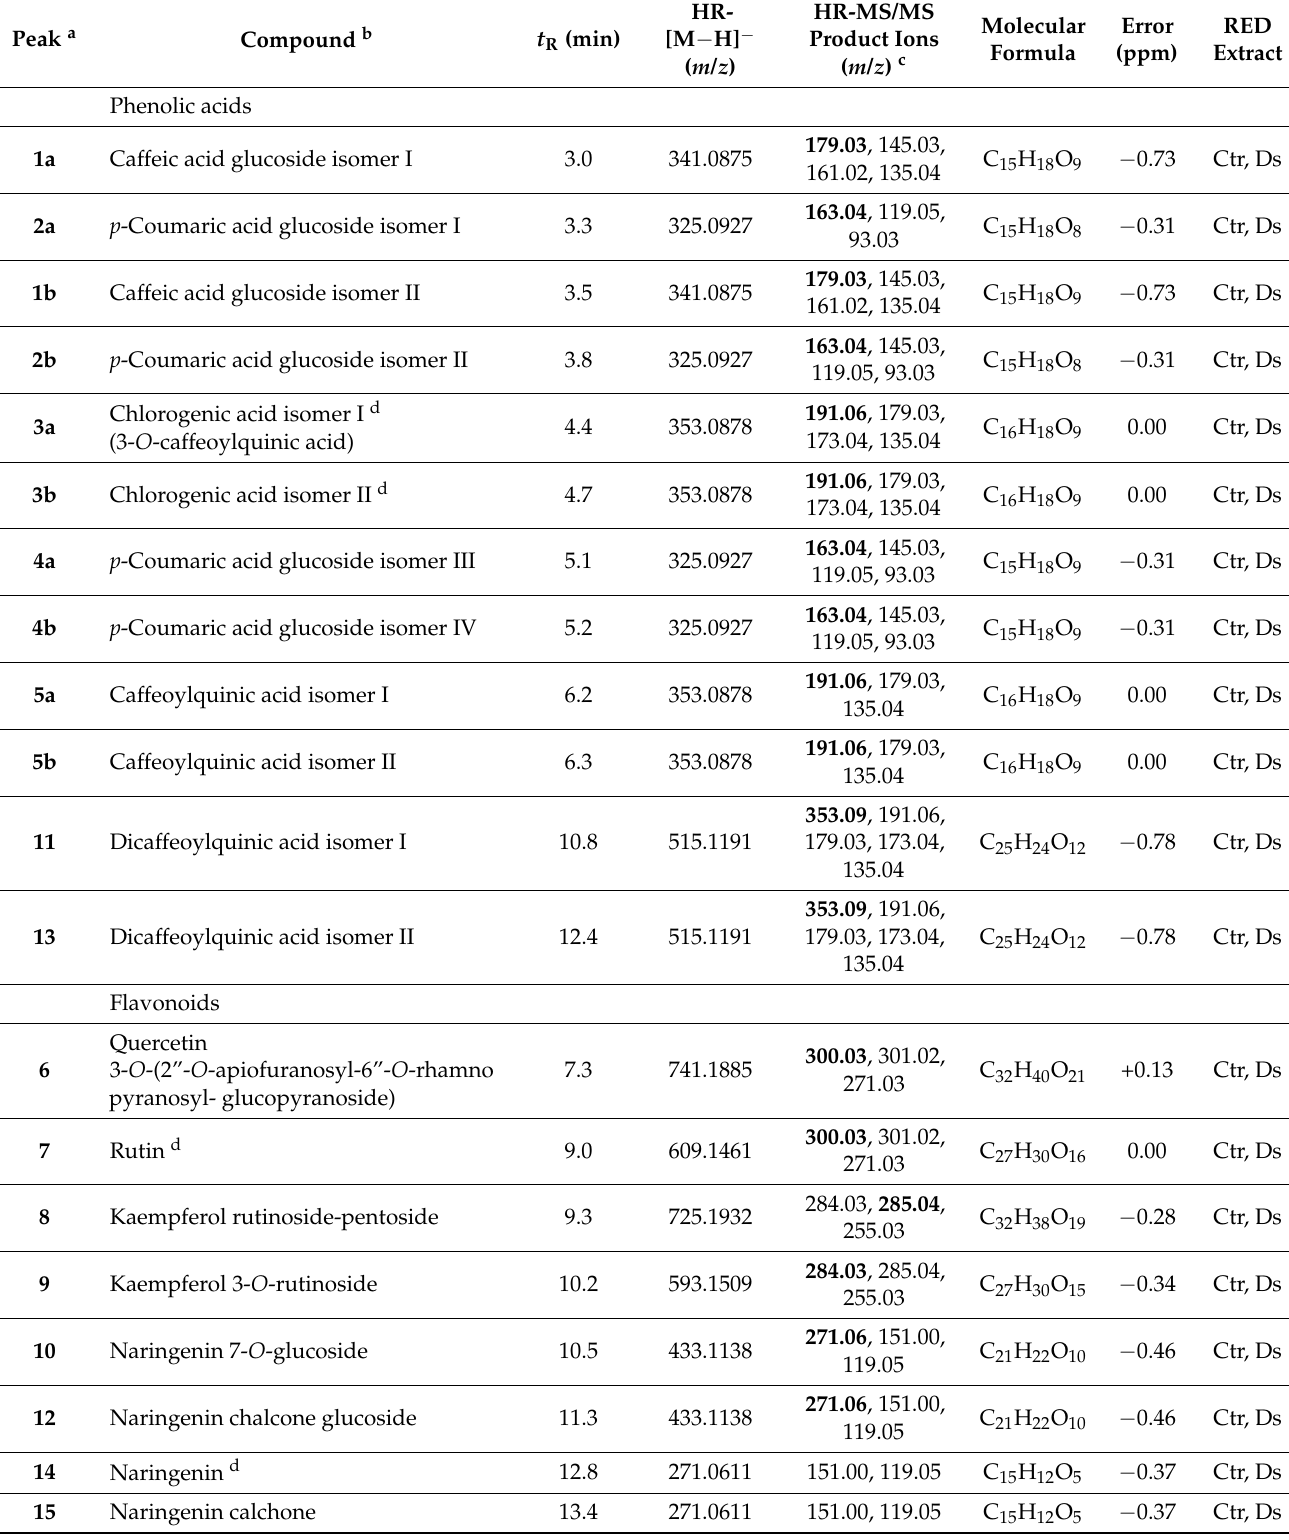
Table 1. UHPLC-HR-ESI-MS/MS data of phenols detected in peel extracts of plants grown in normal (RED-Ctr) and in drought stress (RED-Ds)